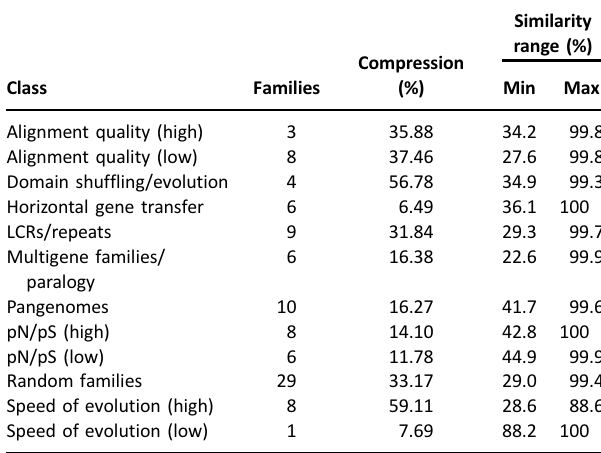
Table 2. Compression averages of the Orthobench